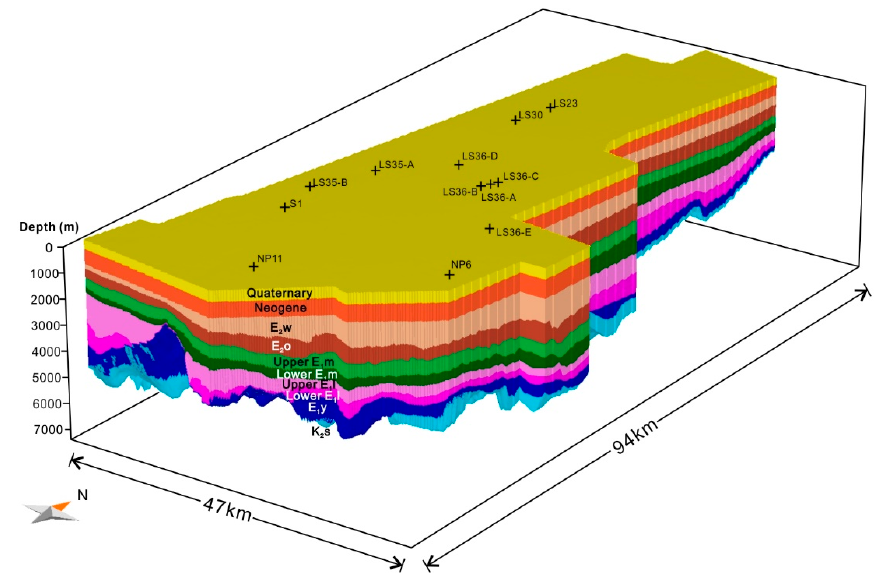
Figure 4. The 3D model dimensions and major layers of the study area (the black box in the Figure 1B) in the Lishui Sag at present-day.